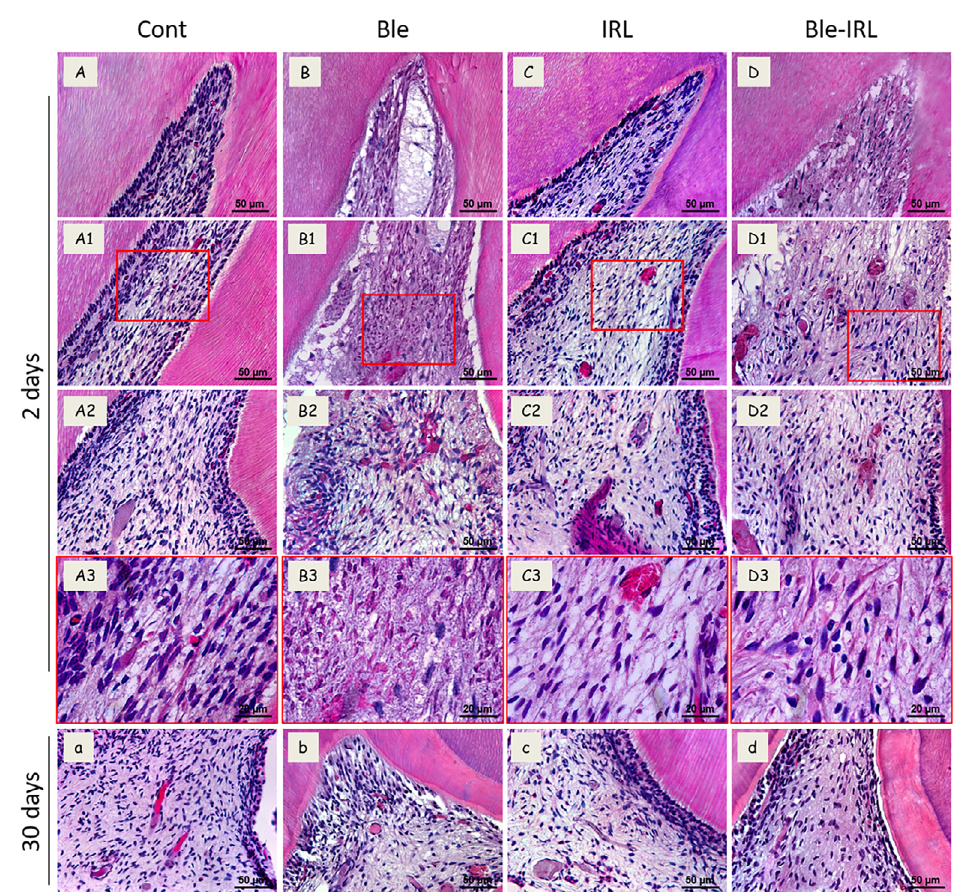
Figure 2- Representative images of the inflammation analysis of the groups at 2 and 30 days. Images of (A-D) occlusal, (A1-D1) middle, and (A2-D2) cervical thirds of groups, and (A3-D3) higher magnification to evidencing pulp tissue of each group, at 2 days. (A-A3) Control group without alteration and absence of inflammation; (B-B3) Bleached group with evident necrosis area and severe inflammatory infiltrate; (C-C3) IRL group with organized pulp tissue and absence of inflammation; and (D-D3) Bleached-IRL group with moderate to mild inflammation. (a-d) Images of (a) control, (b) Bleached, (c) IRL and (d) Bleached-IRL groups at 30 days, evidencing absence of inflammation and presence of tertiary dentine in bleached groups. [400×, 1000×;